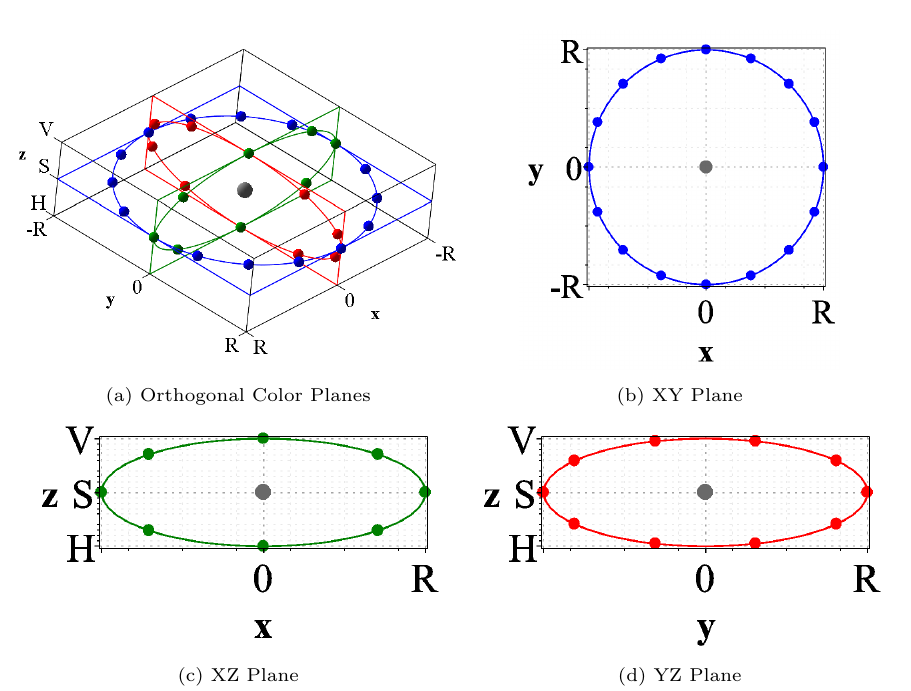
Figure 20. ( a ) General view of OCPP, ( b ) XY (P XY = 16) plane, ( c ) XZ (P XZ = 8) plane, and ( d ) YZ (P YZ = 10)